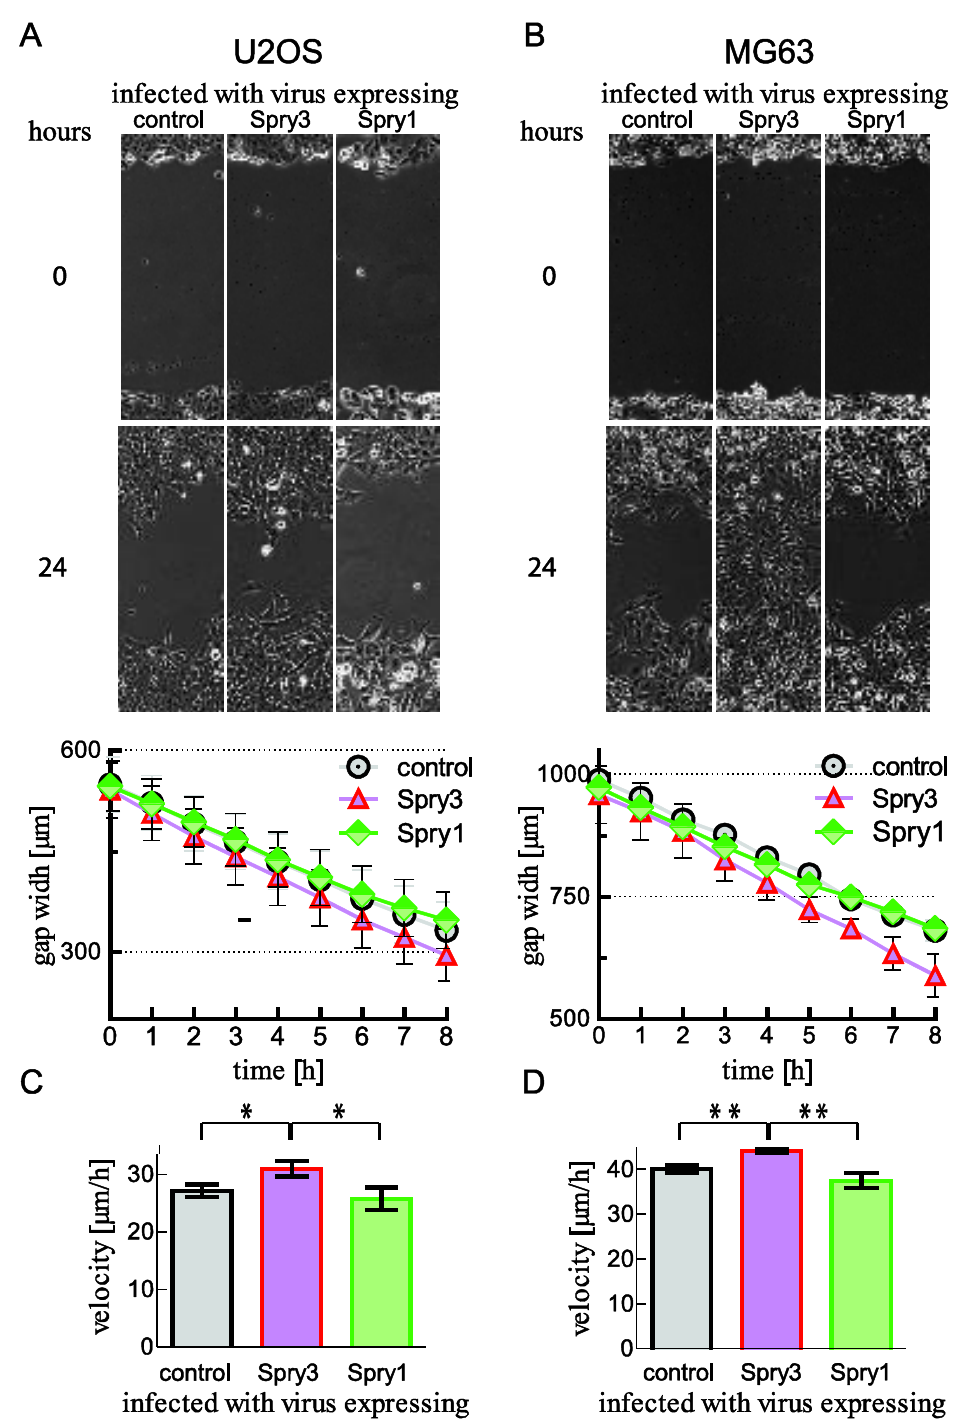
Figure 4. Impact of Spry3 and Spry1 on cell migration in osteosarcoma-derived cells. U2OS ( A ) and MG63 ( B ) cells expressing the indicated proteins were cultured to form a close layer before a scratch assay was performed. Representative pictures taken with a VISITRON Live Cell Imaging System at time points 0 and 24 h are presented. Measurements of three replicative gaps were performed every hour over a time period of eight hours and a representative experiment is depicted. Velocities of four experiments performed in U2OS ( C ) and MG63 ( D ) were calculated using linear regression in GraphPad Prism. The calculated speeds ( µ m/h) of the experiments are depicted as means ± SEM. Using an unpaired t-test, significance was determined. ** p < 0.01; *p <